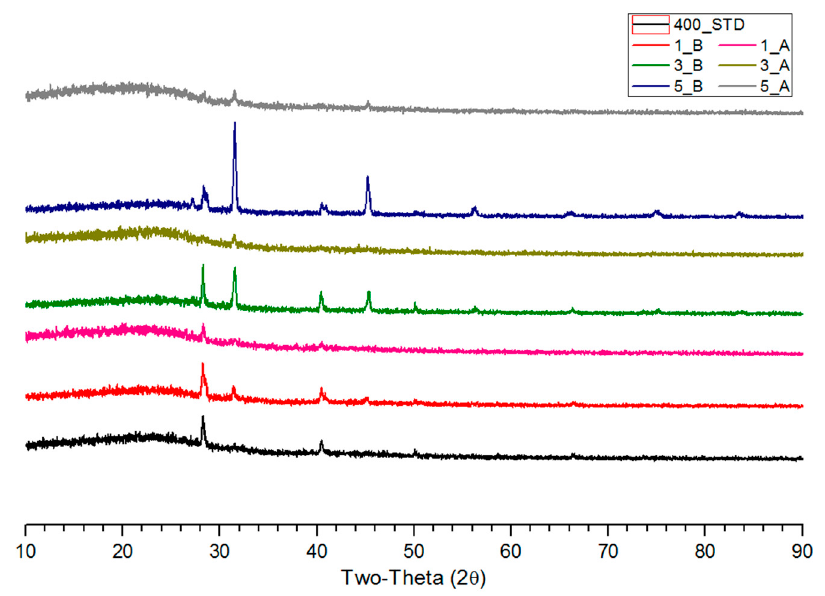
Figure 2. The XRD result of biochar pyrolyzed at 300 ◦ C before and after flushing.